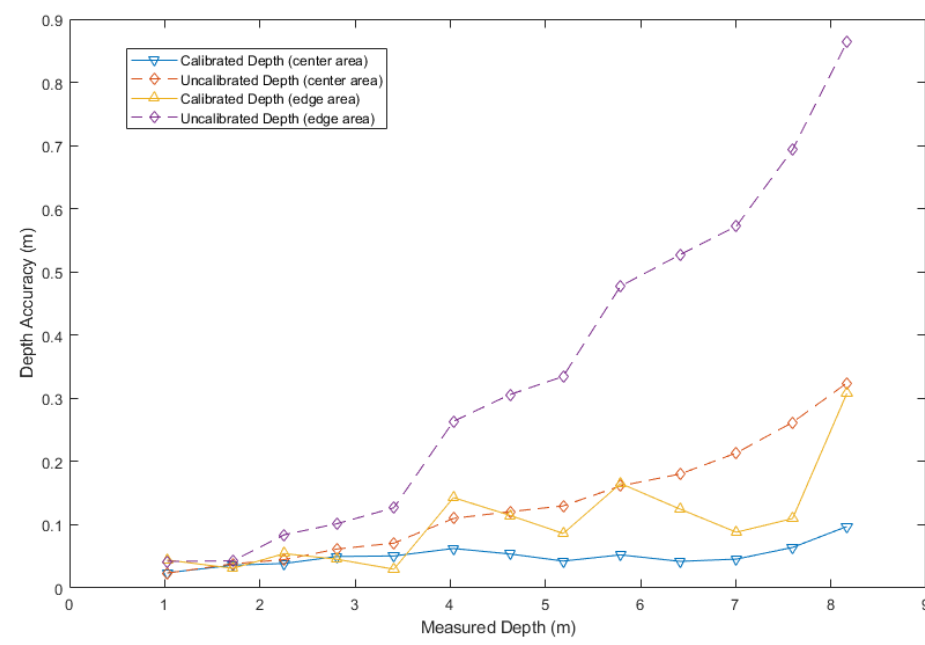
Figure 8. Quantitative analysis of the depth calibration.